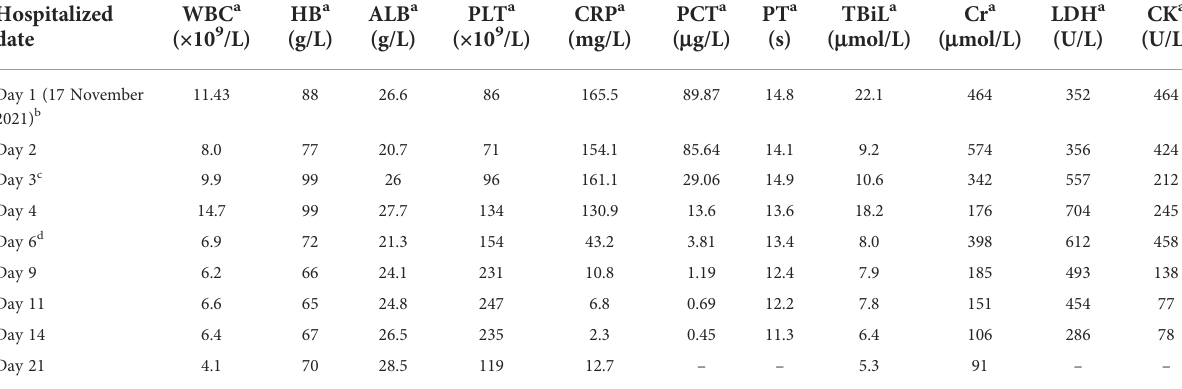
TABLE 1 Laboratory